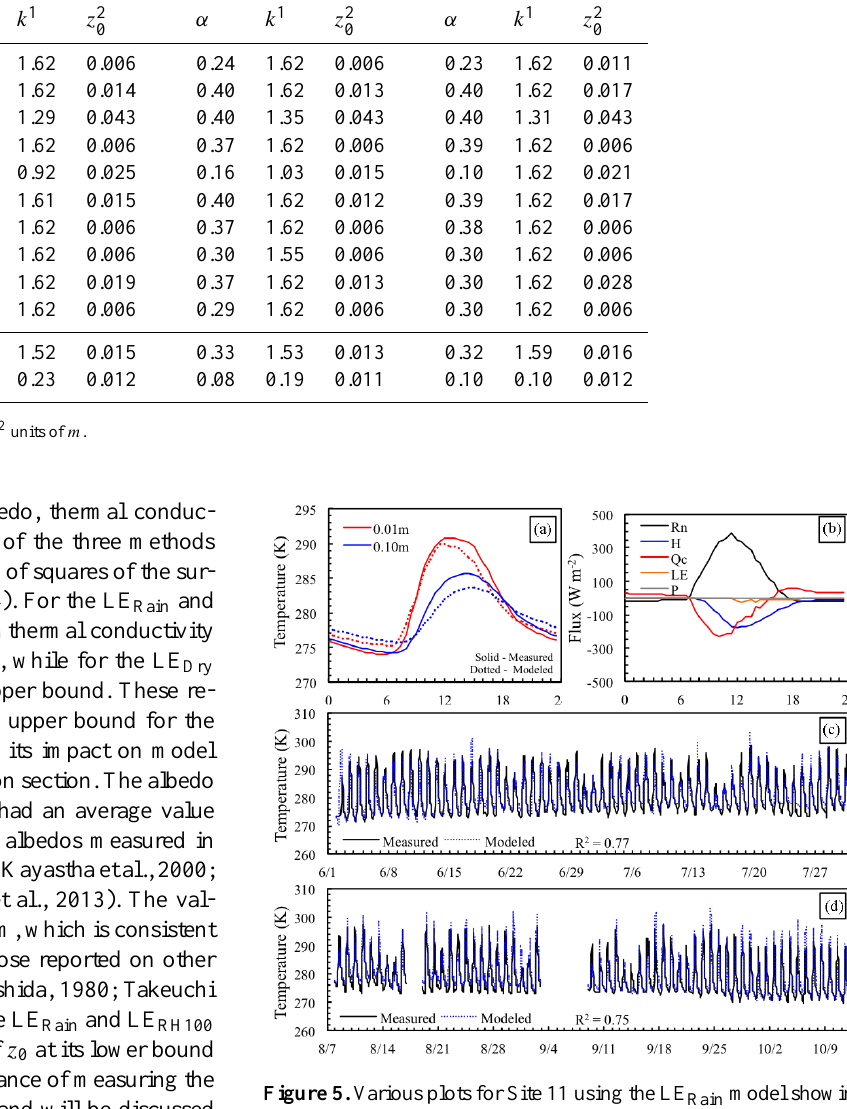
Table 4. Optimized values of albedo, thermal conductivity, and surface roughness for three methods of estimating latent heat flux during the calibration period. LE Rain LE RH100 LE Dry Site α